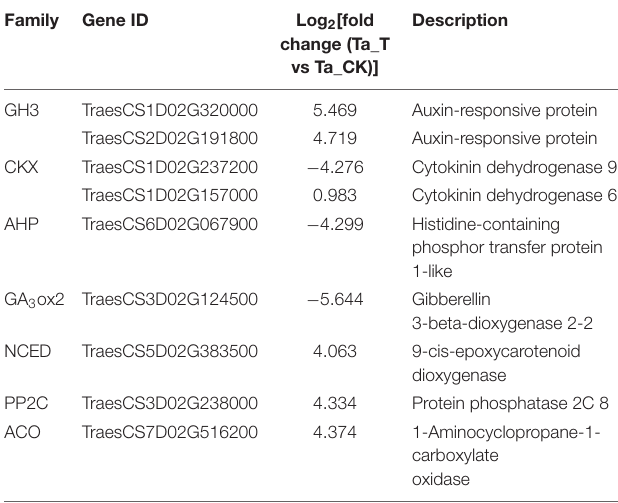
TABLE 2 | Candidate genes involved in different tillering responses to 2,4-D isooctyl ester of Triticum aestivum versus Aegilops tauschii selected from transcriptome